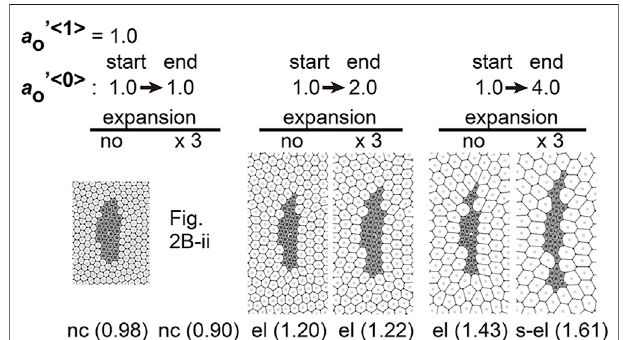
FIGURE 7 | Differences in preferred cell areas cause cell cluster elongation in a manner independent to fi eld expansion. Simulations were performed under conditions with temporal changes in the preferred cell areas in the type 0 cells, whereas the values of other parameters were assigned to be equal for both two cell types: a ′ < 0 > O